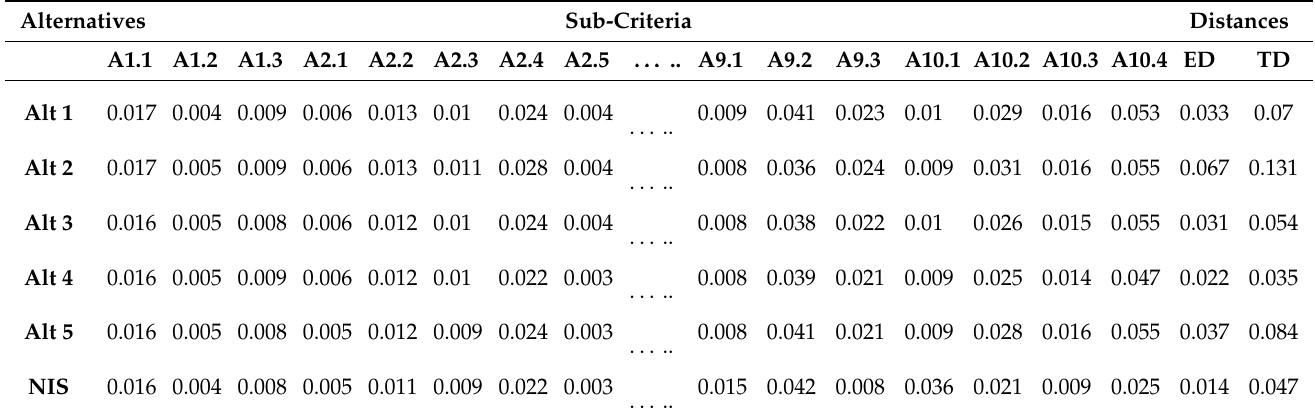
Table 17. Weighted normalized decision matrix, NIS, ED and TD.